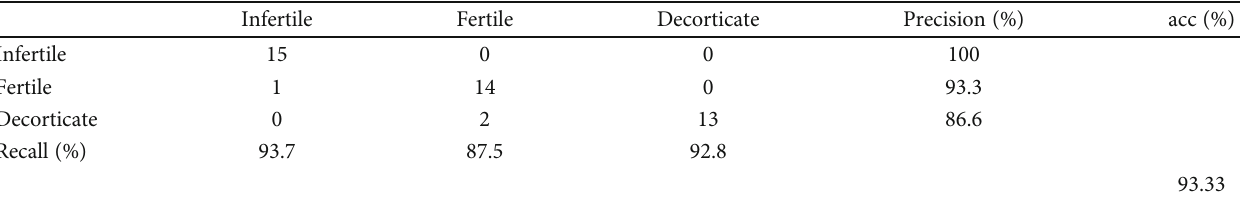
Table 2: Classi fi cation result of parasite egg